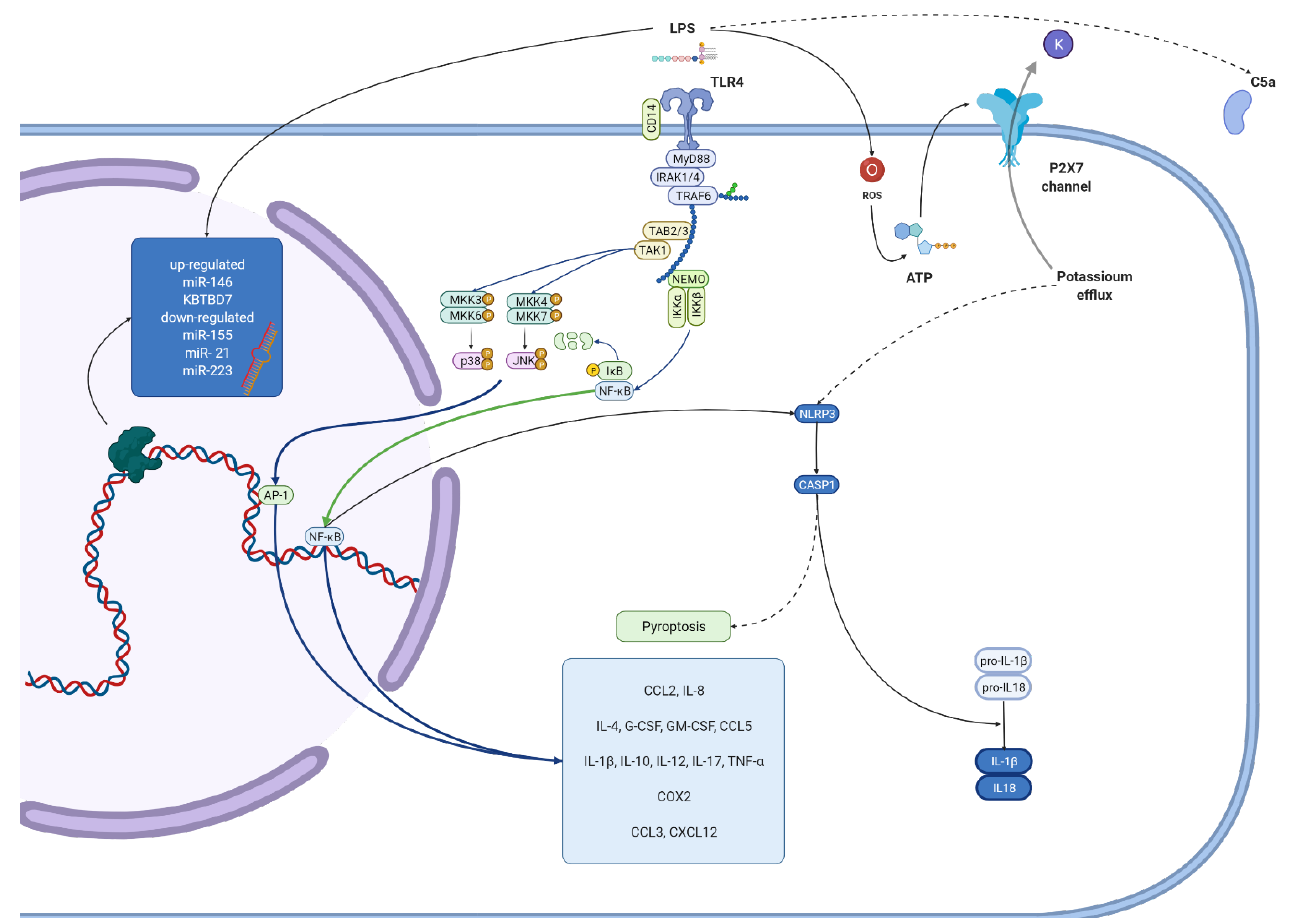
Figure 5. Molecular effects exerted by lipopolysaccharides on fibroblasts Figure summarizes results from studies conducted on fibroblasts, regardless of LPS origin. TLR pathway acts via NF- κB and MAPK, promotes release of interleukins, chemokines and growth factors. Deep blue arrows present this pathway. Pathways and particles activated in LPS-treated cells are presented in both deep blue brackets and by protein images with their names. Black arrows represent positive stimulation, dashed arrows show indirect activation, red ones—inhibition, green—translocation to another cell compartment. Created with BioRender.com 7.12.2020.